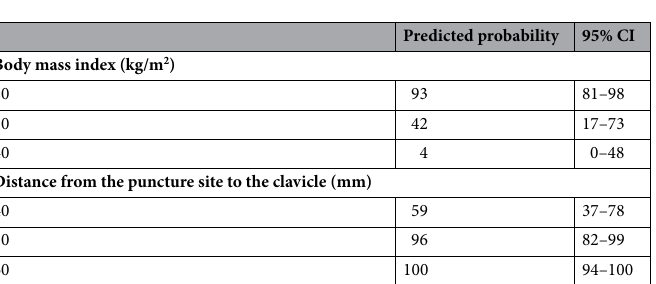
Figure 3. Predicted probability for successful visualization of the parallel guidewire from general additive model. ( a ) Relationship between body mass index and probability of successful visualization of the parallel guidewire. ( b ) Relationship between distance from the puncture site to the clavicle and probability of successful visualization of the parallel guidewire. Trend lines are presented as dark blue lines and the blue ranges indicate 95% confidence intervals.